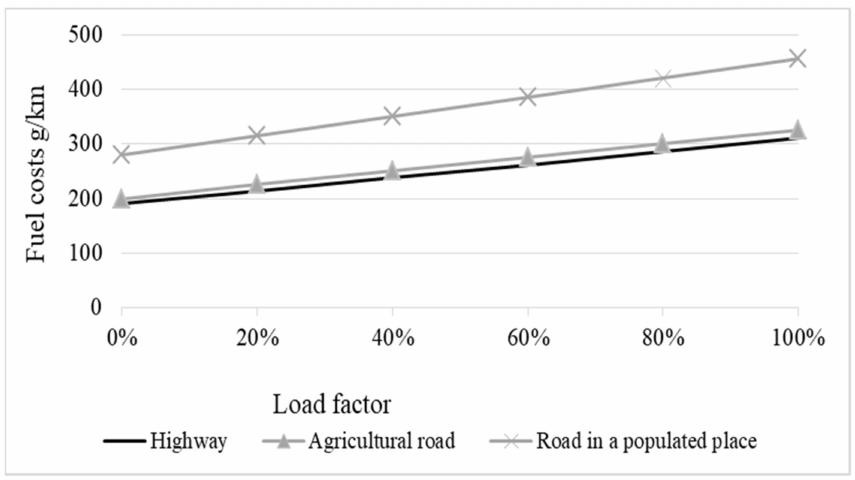
Figure 3. Dependency of fuel costs on a load factor